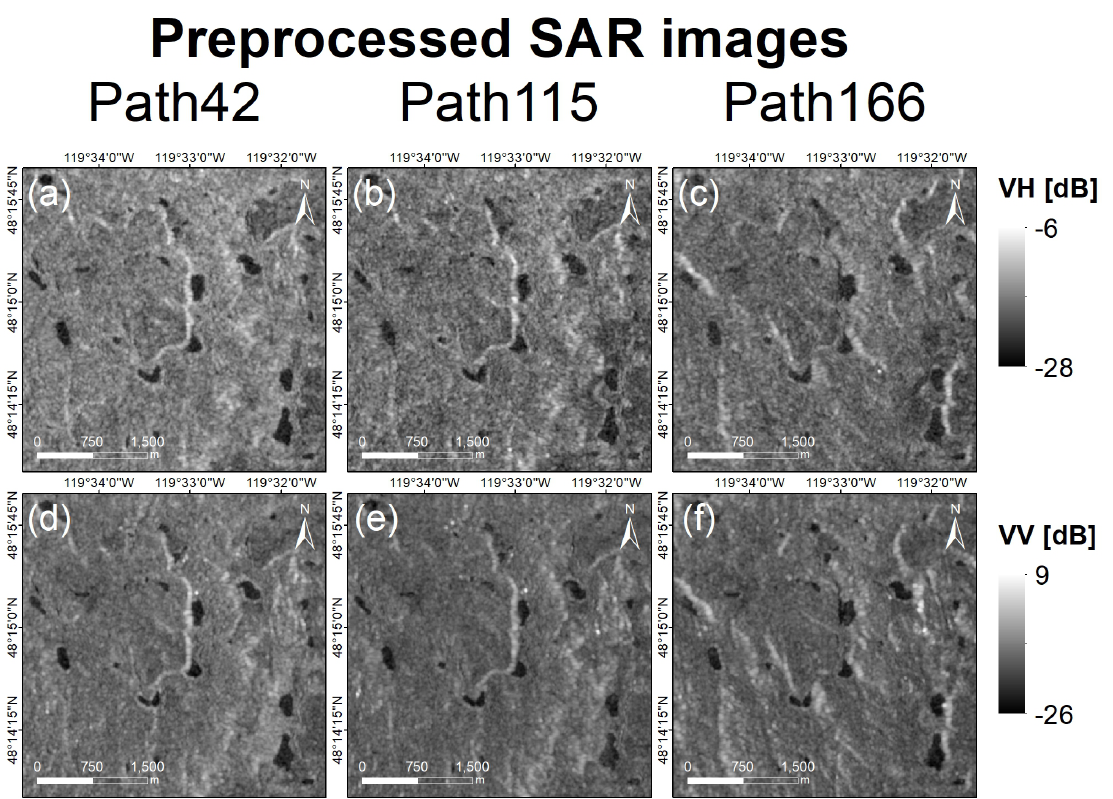
Figure 7. Examples of preprocessed SAR images (VH polarization): ( a ) SAR image taken from Path42 on 25 July 2018. The average intensity of the image is − 20.41dB. ( b ) SAR image taken from Path 115 on 18 July 2018. The average intensity of the image is − 19.18dB. ( c ) SAR image taken from Path166 on 22 July 2018. The average intensity of the image is − 19.25dB. Examples of preprocessed SAR images (VV polarization): ( d ) SAR image taken from Path42 on 25 July 2018. The average intensity of the image is − 13.16dB. ( e ) SAR image taken from Path 115 on 18 July 2018. The average intensity of the image is − 12.08dB. ( f ) SAR image taken from Path166 on 22 July 2018. The average intensity of the image is −